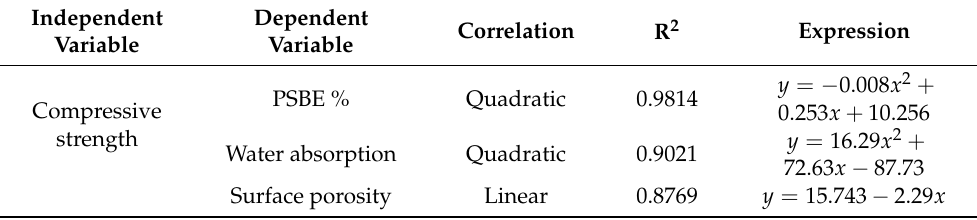
Figure 8. Porosity and compressive strength of mortar. Table 8. Regression analysis of factors affecting mortar compressive strength.